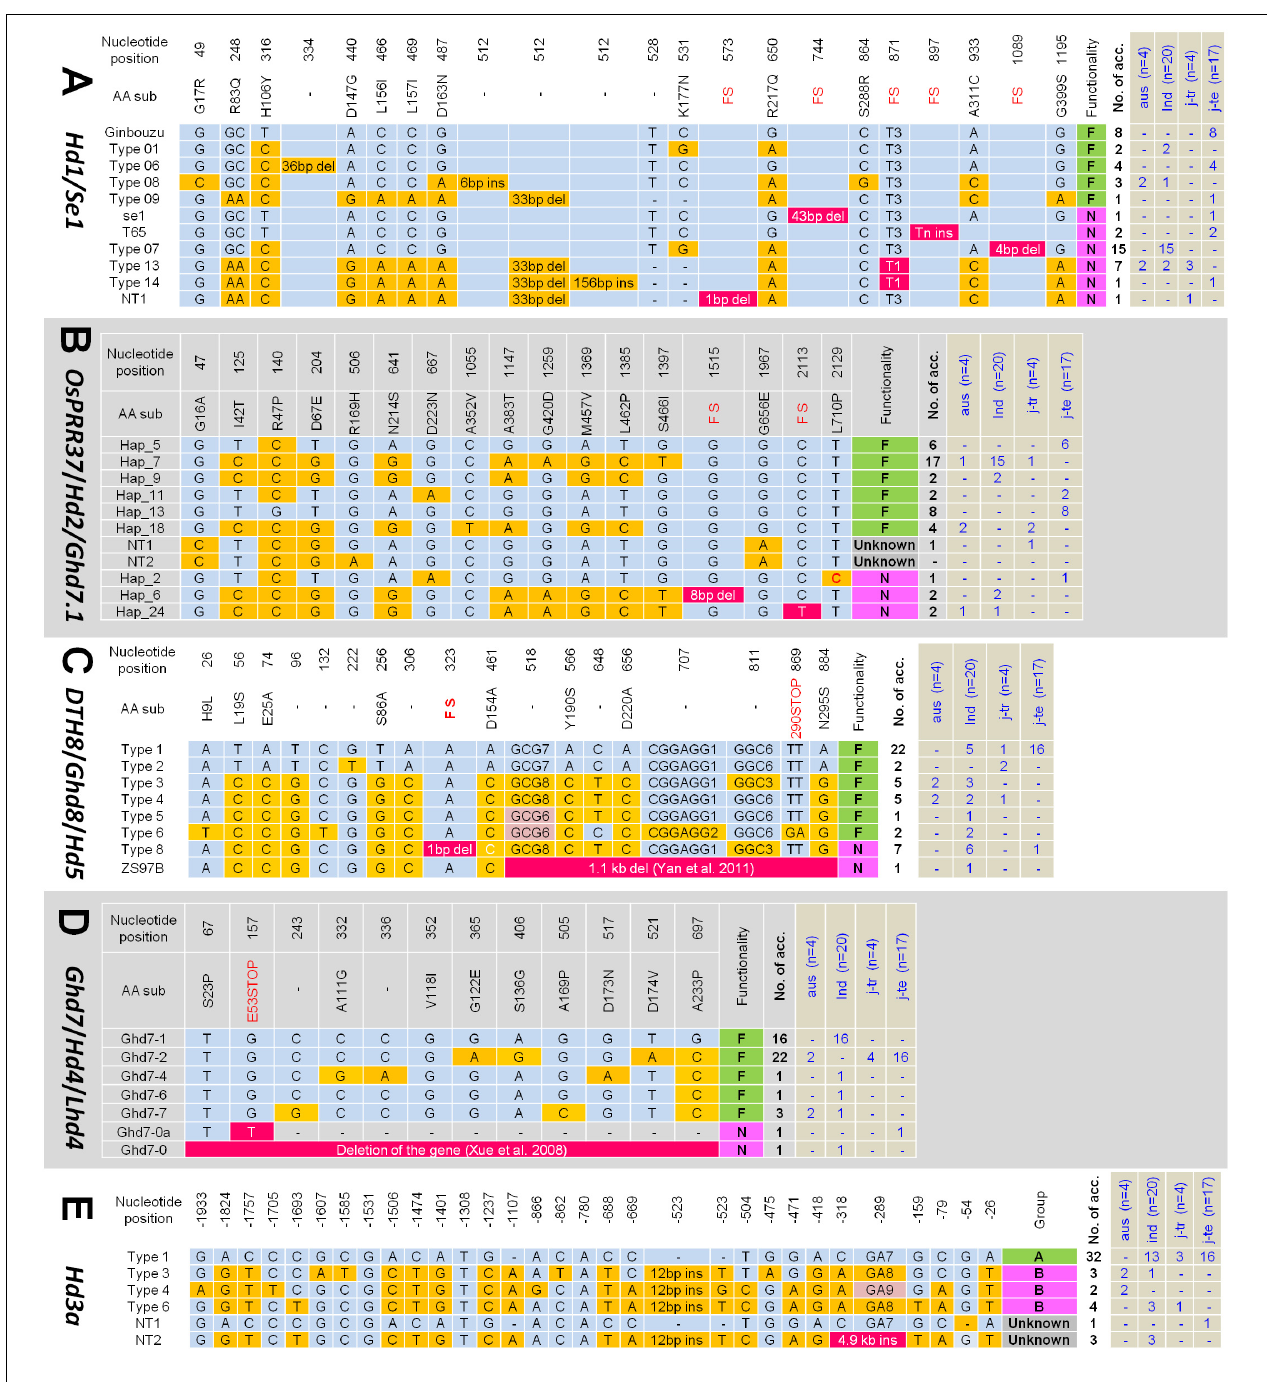
FIGURE 2 | Allele types of the five major flowering genes in the 45 diverse accessions. The allele frequencies in each rice type are presented at the right panel (blue letter). The nucleotide position referred to the protein coding sequence (CDS) or promoter sequence. (A) Hd1 alleles. Reference: Ginbouzu (GenBank Accession No. AB041840.1). (B) OsPRR37 alleles. Reference: Nipponbare (MSU ID: Os07g49460 ). (C) DTH8 alleles. Reference: Nipponbare (MSU ID: Os08g07740 ). (D) Ghd7 alleles. Reference: Minghui 63 (GenBank Accession No. EU286801.1). (E) Hd3a promoter alleles. Reference: Nipponbare (MSU ID: Os06g06320 ). FS, frame